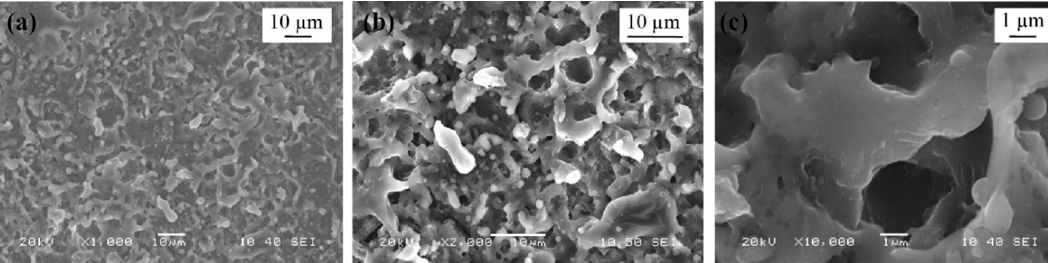
Table 1. Plasma conditions used for preparation of samples. Sample Name